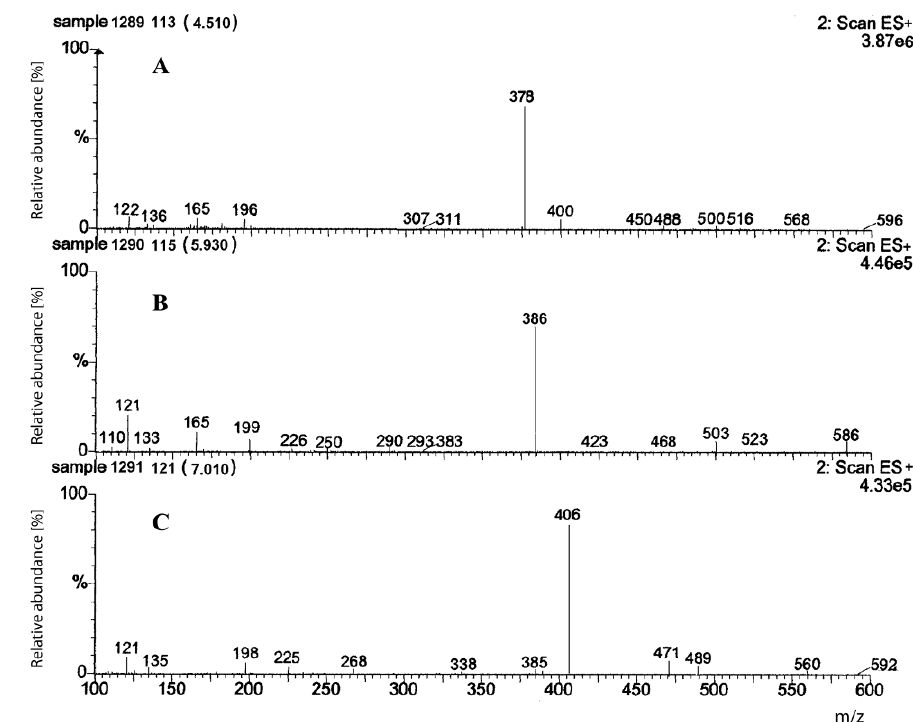
Figure 5. ES+ mass spectrum (A) for IMD degradation product I, (B) for IMD degradation product II and (C) for pure IMD.